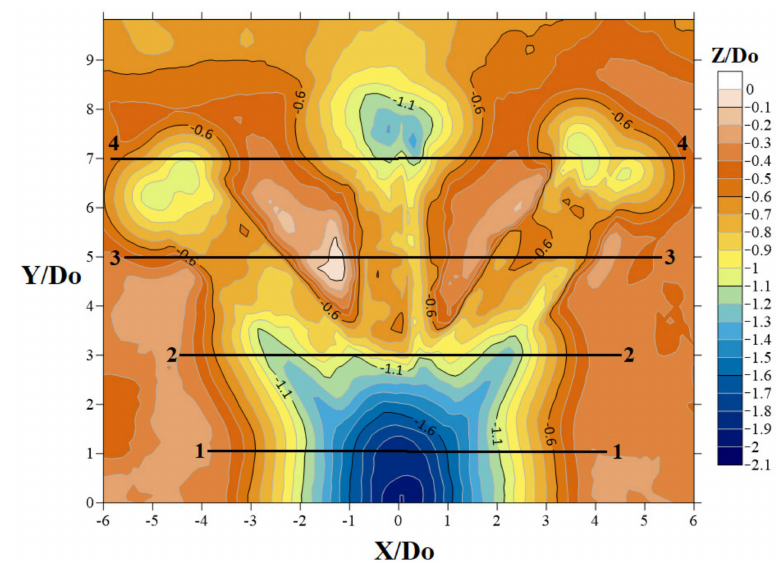
Figure 6. Cross-section plane of the sediment flushing